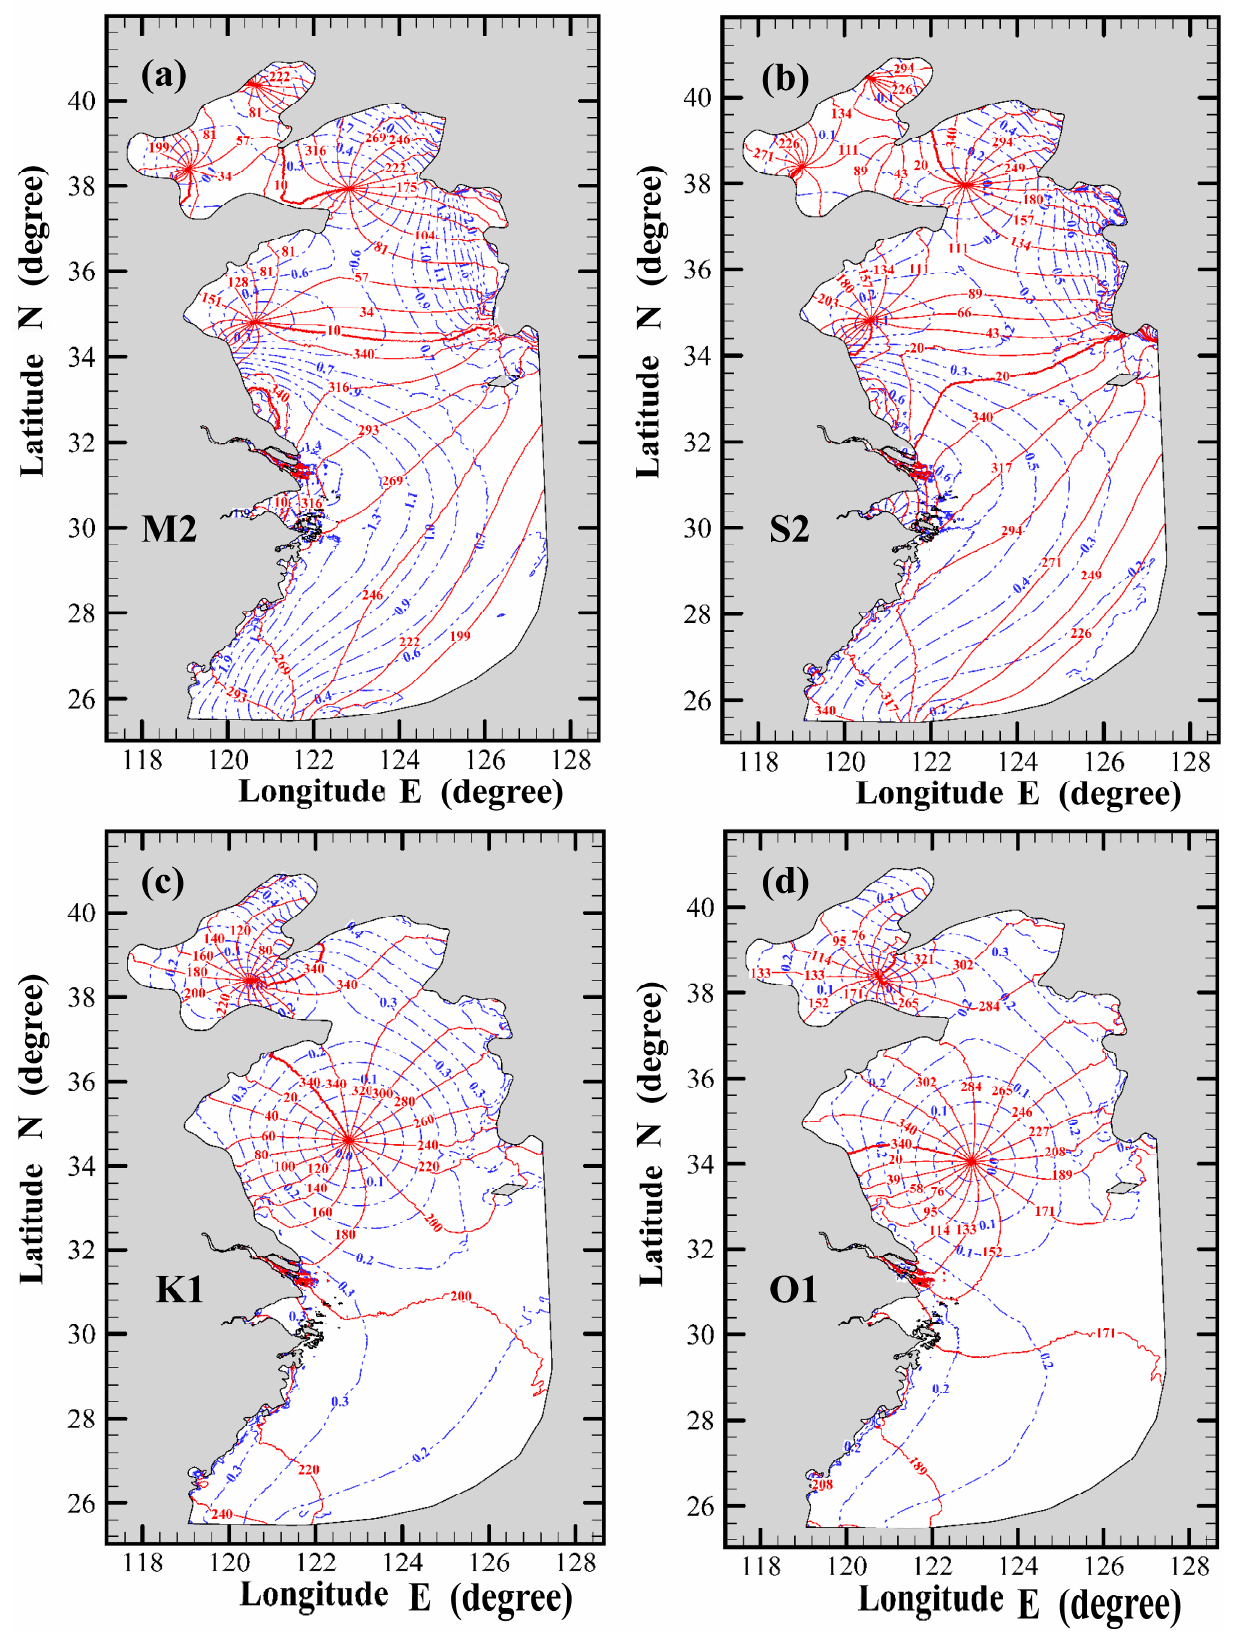
Figure 8. Distributions of the co-amplitude (blue dashed lines; unit: meter) and co-phase (red solid lines; unit: degree) of the M2, S2, K1 and O1 tide constituents around the East China Sea, Yellow Sea and the Bohai Sea.